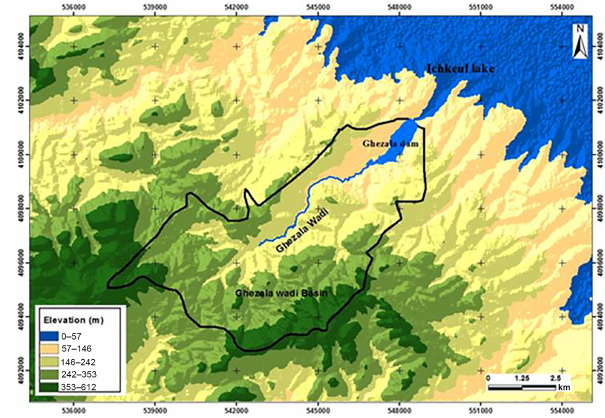
Figure 1. Location of Ghézala